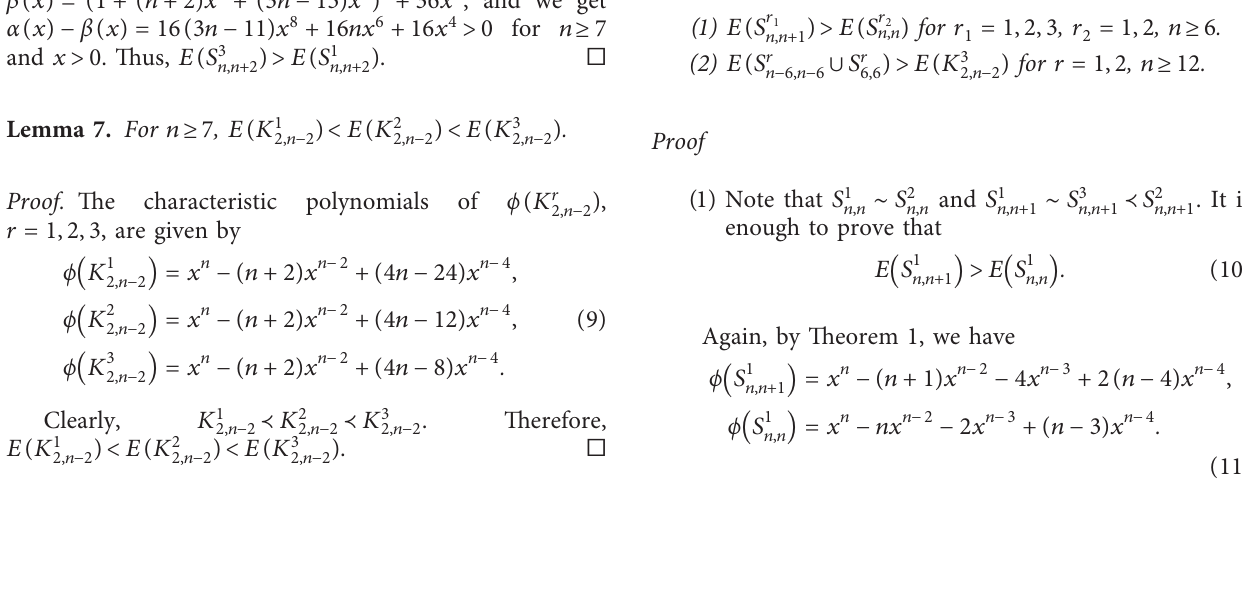
Figure 6: Bicyclic signed graphs with minimal energy. (a) S 1